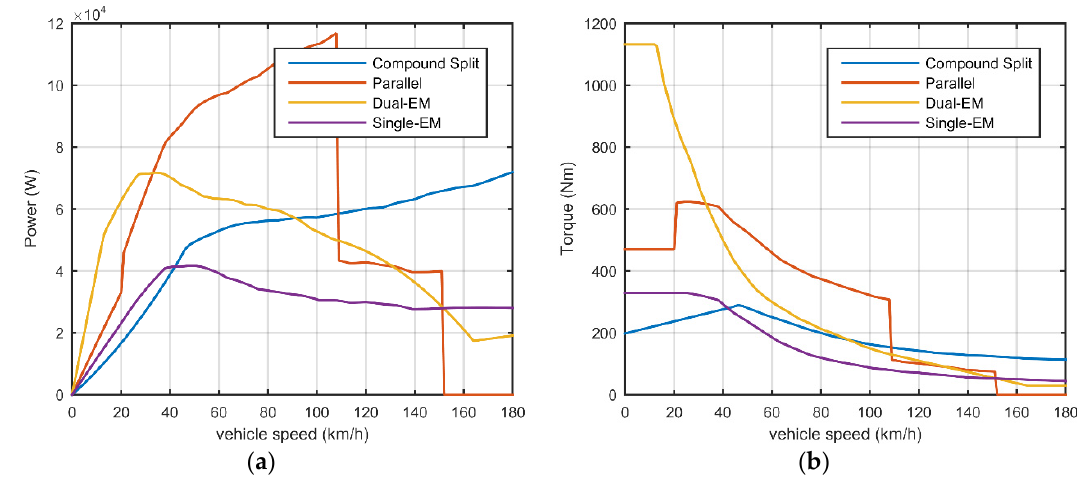
Figure 8. ( a ) Maximum output power; ( b ) Maximum output torque.